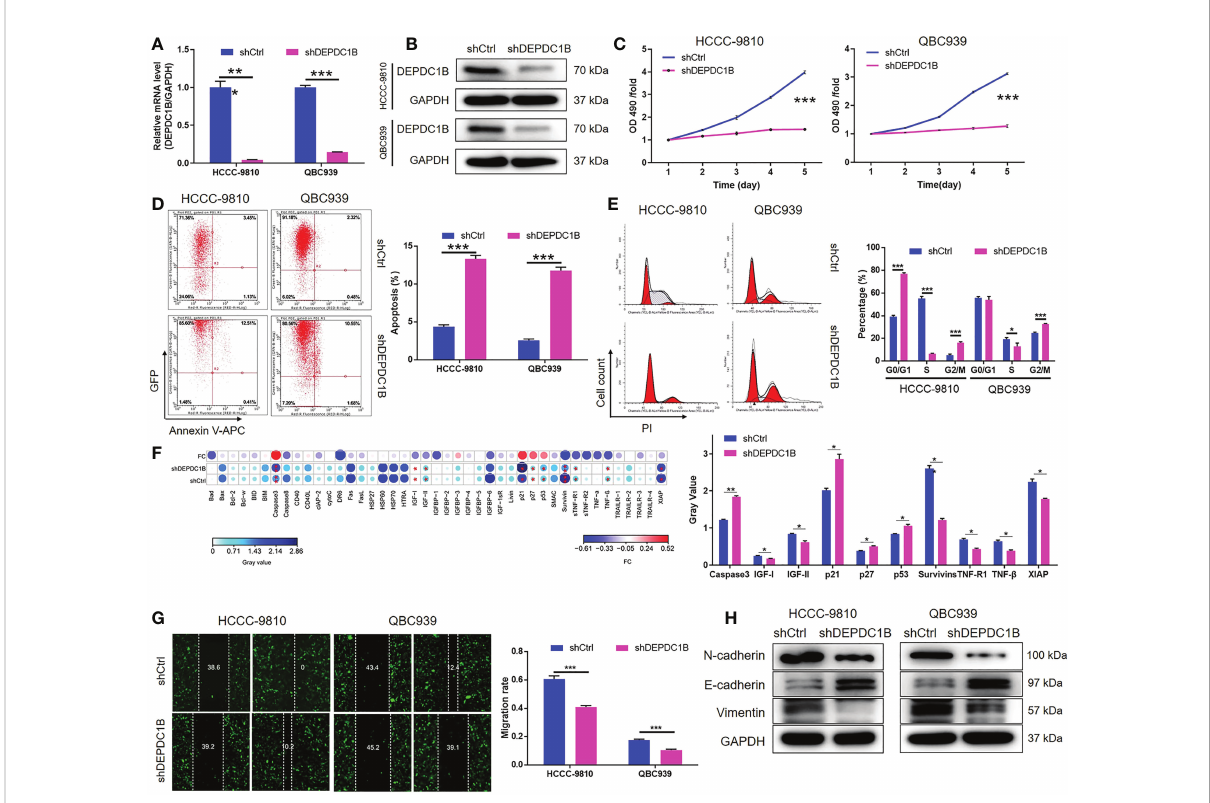
FIGURE 2 DEPDC1B knockdown inhibited CCA development in vitro . (A, B) Cell models with or without DEPDC1B knockdown were constructed by transfecting shDEPDC1B or shCtrl. The knockdown ef fi ciency of DEPDC1B in HCCC-9810 and QBC939 cells was assessed by qPCR (A) and Western blotting (B) . (C) MTT assay was employed to show the effects of DEPDC1B on cell proliferation of HCCC-9810 and QBC939 cells. (D) Flow cytometry was performed to detect the cell apoptosis of HCCC-9810 and QBC939 cells with or without DEPDC1B knockdown. (E) Cell- cycle distribution was estimated in HCCC-9810 and QBC939 cells with or without DEPDC1B knockdown. (F) Human Apoptosis Antibody Array was performed to detect and compare the expression of apoptosis-related proteins in HCCC-9810 cells with or without DEPDC1B knockdown. (G) The effects of DEPDC1B on the cell migration ability of HCCC-9810 and QBC939 cells were evaluated by wound healing assay. (H) Western blotting was performed to show the effects of DEPDC1B knockdown on expression of EMT-related proteins. The representative images were selected from at least three independent experiments. Data were shown as mean ± SD (n = 3). * P < 0.05, ** P < 0.01, *** P <